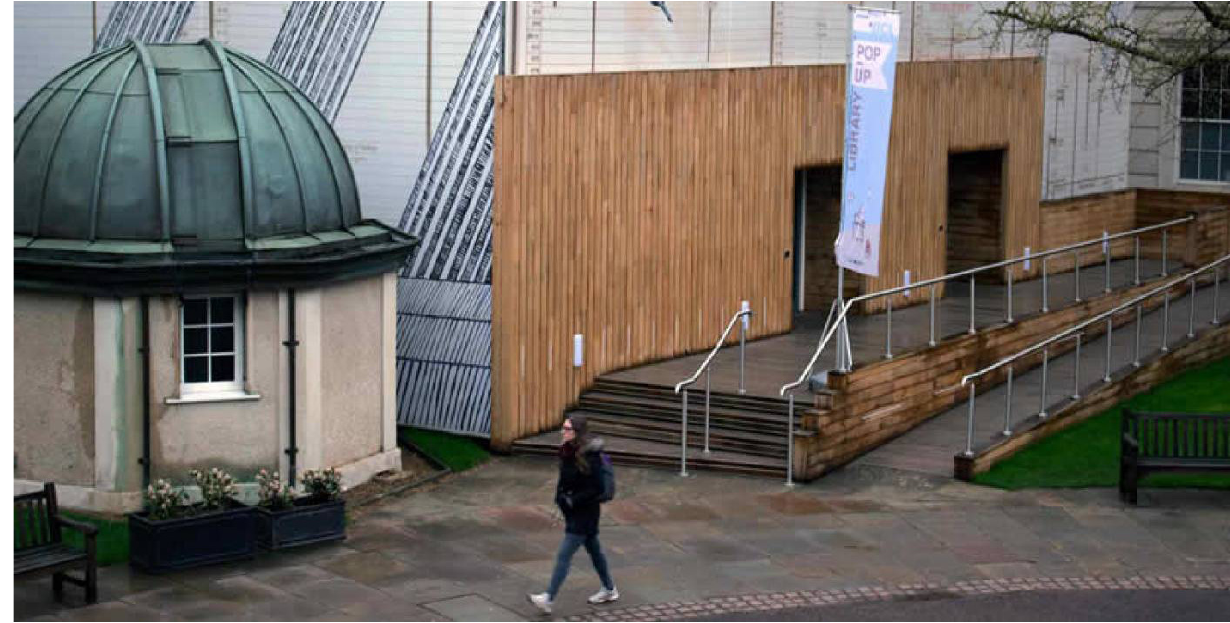
Figure 1. UCL’s Main Quad Temporary Pop‐Up. Source: UCL